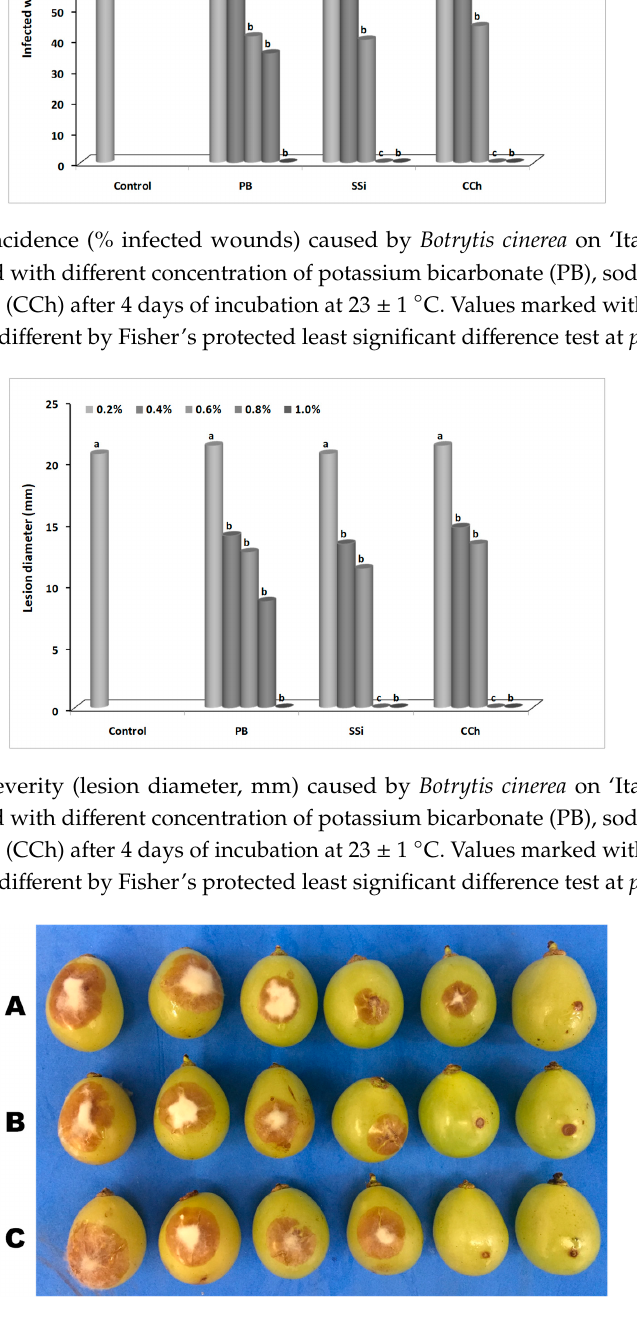
Figure 3. Effect of five concentrations of potassium bicarbonate (PB), sodium silicate (SSi), and calcium chelate (CCh) on gray mold disease of grapes. ( A ) Berries inoculated with Botrytis cinerea (10 6 conidia mL − 1 ) and treated with PB at 0.0, 0.2, 0.4, 0.6, 0.8, and 1.0% from left to right respectively. ( B ) Berries inoculated with B. cinerea conidial suspension and treated with SSi at 0.0, 0.2, 0.4, 0.6, 0.8, and 1.0% respectively. ( C ) Berries inoculated with B. cinerea conidium suspension and treated with CCh at 0.0, 0.2, 0.4, 0.6, 0.8, and 1.0%